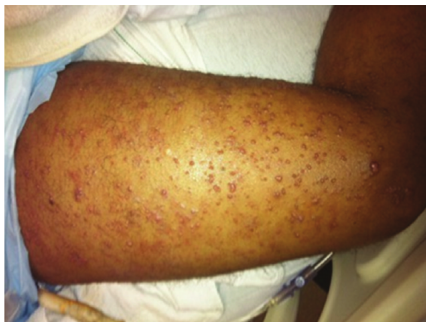
Figure 2: Erythematous follicular papules sometimes coalescing and forming nodules on the patient’s right lower extremity.